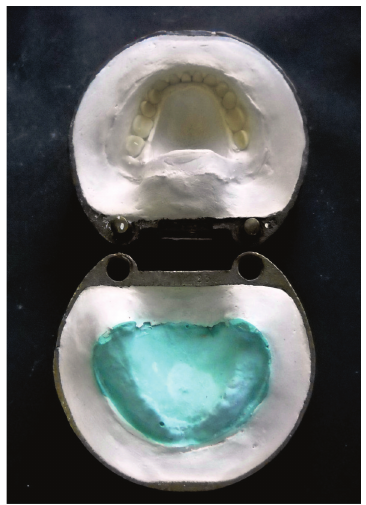
Figure 9: Packing of heat cure acrylic resin.